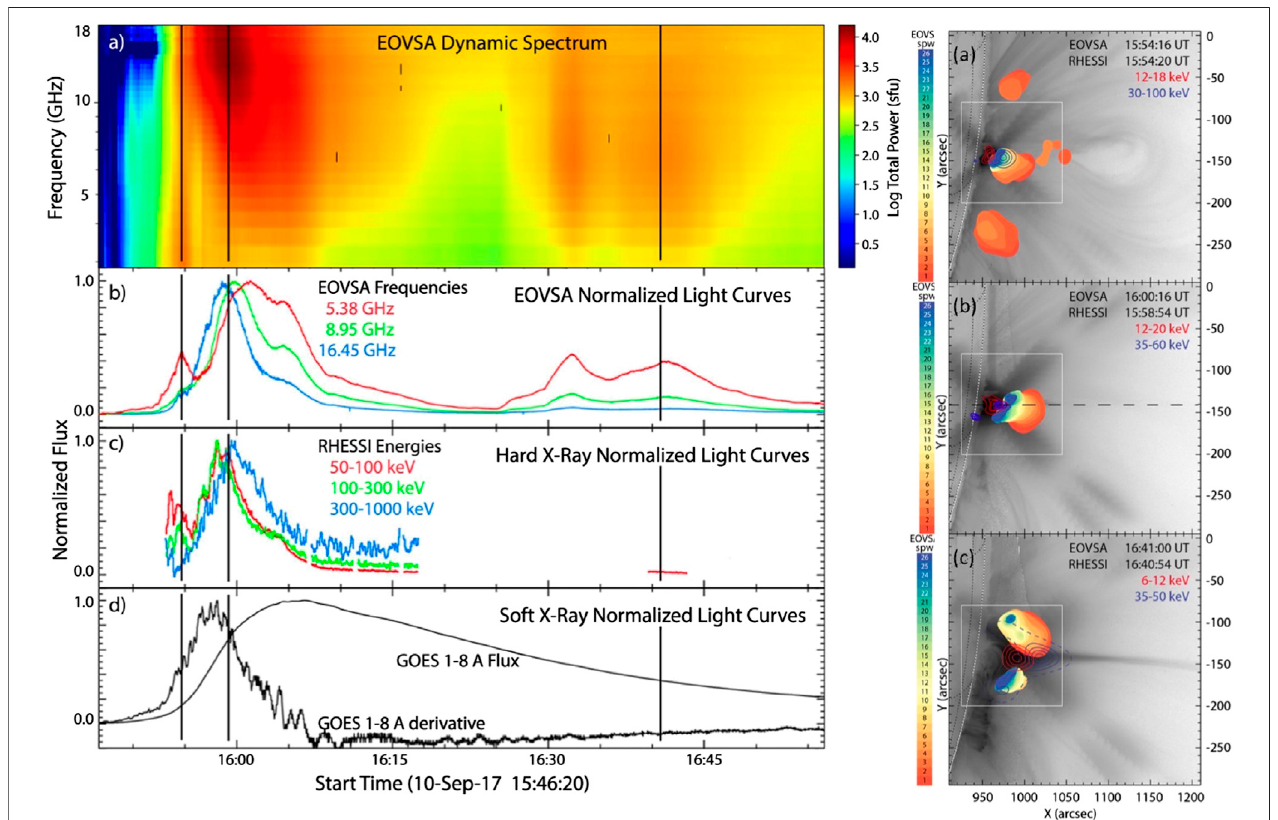
FIGURE4| Microwaveobservationsofthelargeeruptive fl areon2017Sep10.AdaptedfromGaryetal.(2018).Leftpanel:Timehistoriesofmicrowaves (AandB) , hard (C) and soft (D) X-rays, with the time derivative of the SXR fl ux in (D) . Right panel: EOVSA maps at three instants marked by vertical lines in the left panel, on top of SDO/AIA images (19.3 nm) (negative gray shading). The color scale shows frequencies, from 1 GHz (red) to 26 GHz (blue). The blue and red contours show X-ray emission (RHESSI) in the energy ranges (6 – 12) keV and (35 – 50) keV, respectively. ©AAS. Reproduced with